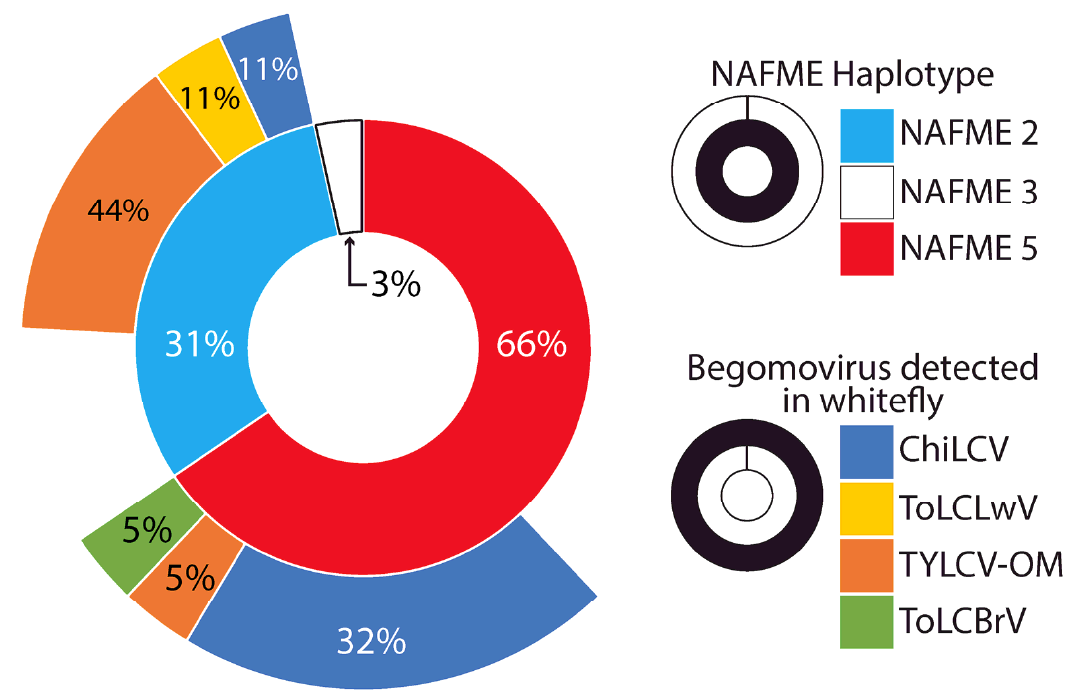
Figure 3. Frequency of Bemisia tabaci NAFME haplotypes (inner chart layer) and begomoviral species (outer chart layer) detected in whitefly extracts.